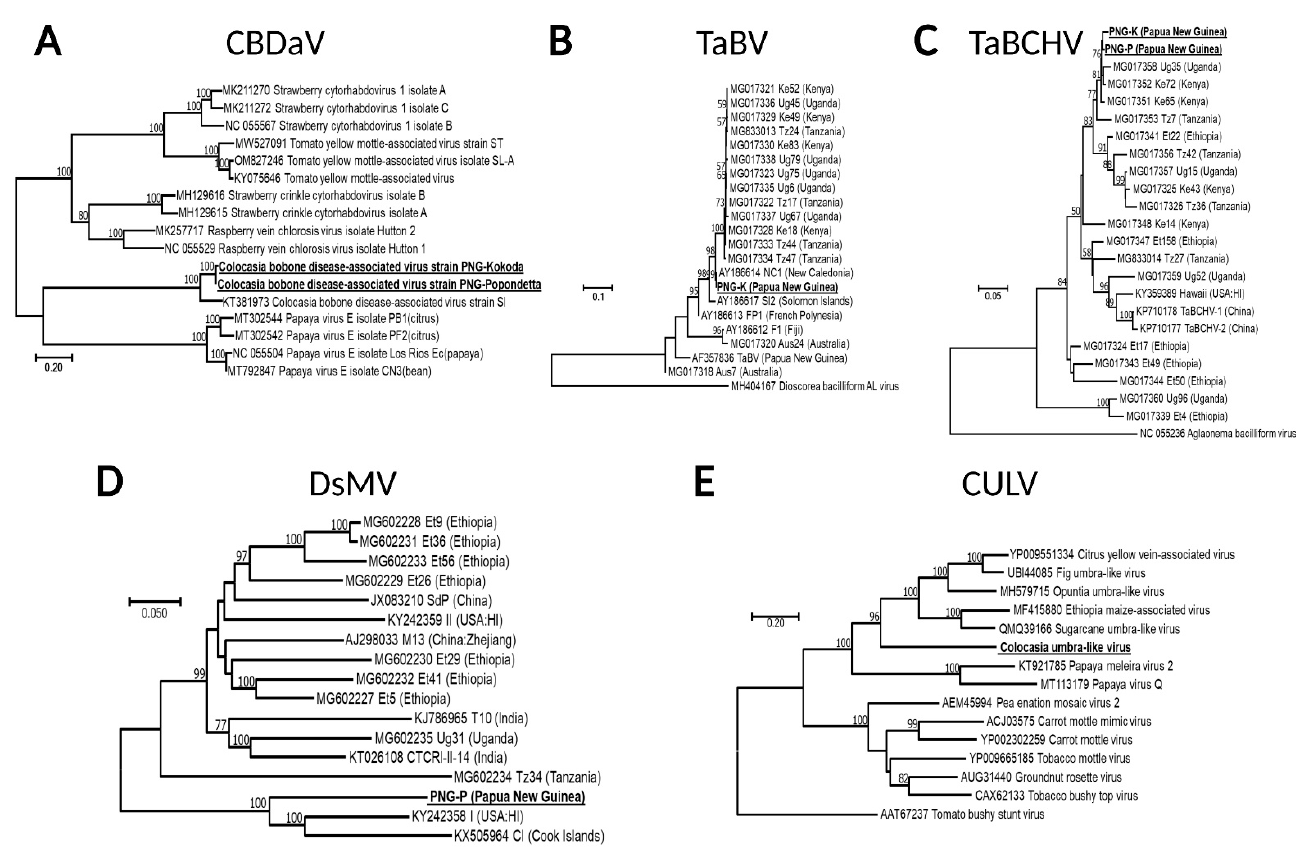
Figure 3. Phylogenetic relationships of CBDaV, TaBV, TaBCHV, DsMV, and CULV with their closest homologs. Maximum likelihood algorithm with 1000 bootstrap repetitions as branch support was used to infer phylogenies of nucleotide or amino acid sequences and their best model of evolution. ( A ) CBDaV (whole genome sequence, LG + G + I), ( B ) TaBV and ( C ) TaBChV (partial nucleotide sequence, GTR + G + I); ( D ) DsMV (whole genome sequence, GTR + G + I), ( E ) CULV (RdRp protein sequence, GTR + G + I).